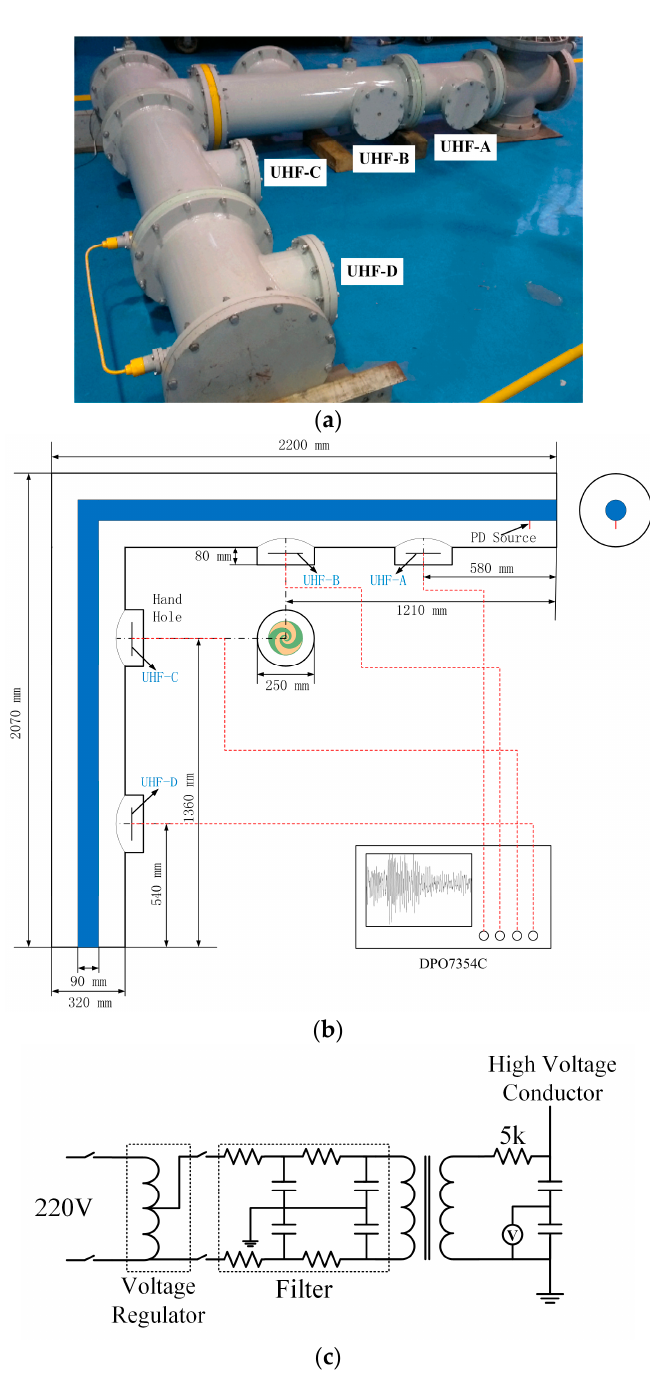
Figure 1. Experimental Setup: ( a ) GIS tank and placements of UHF sensors; ( b ) geometrical dimensions of GIS tank; and ( c ) schematic diagram of experimental circuit.